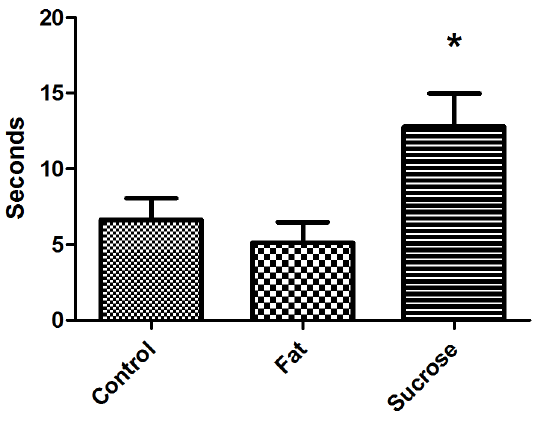
Figure 3. The Triple test, time spent in the aversive centre of the open field at post-diet test. Mice on high-sucrose diet spent significantly more time here than the mice on high-fat diet, indicating a decreased anxiety (p=0.009). A strong tendency of a similar difference to mice on control diet supports this decreased anxiety in mice fed a high-sucrose diet (p=0.052). Mean with